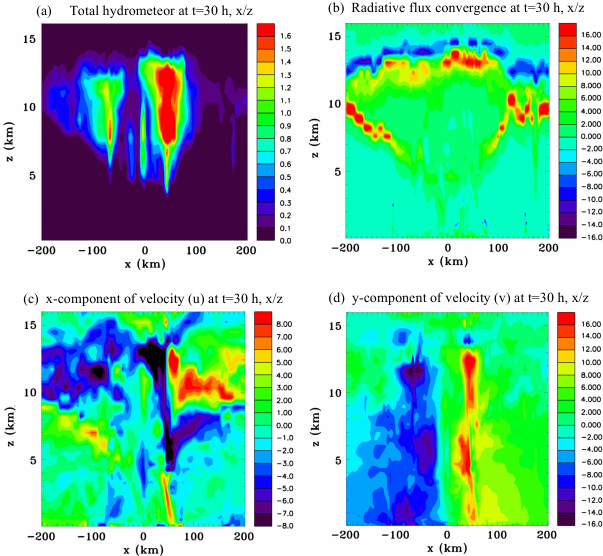
Figure 21. Experiment 13: full physics with radiation in the whole domain. Vertical sections at t = 30h of (a) the total hydrometeor mixing ratio (gkg − 1 ), (b) radiative flux convergence at t = 21h ( × 10 − 5 Ks − 1 ), (c) x -component of velocity, u (ms − 1 ), and (d) y -component of velocity, v (ms − 1 ).